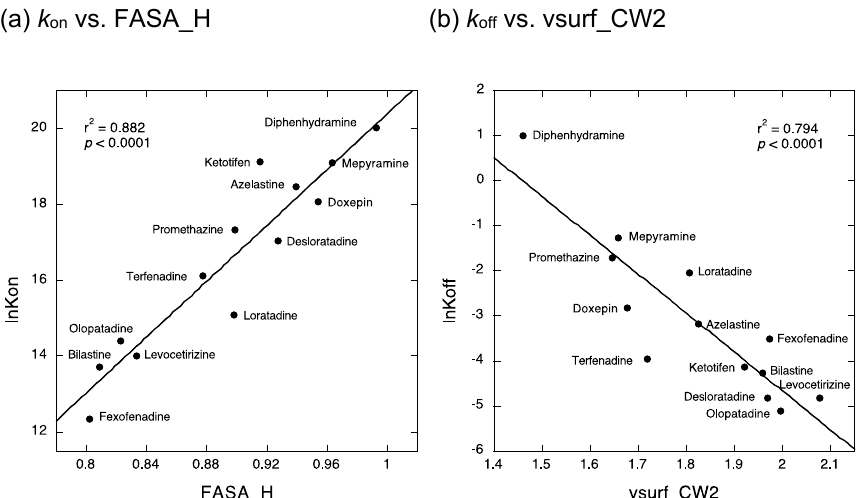
Figure 5. Quantitative structure–activity relationship (QSAR) analyses to identify the physicochemical properties of antihistamines that determine their kinetic binding parameters. Two descriptors, FASA_H (water-accessible surface area of all hydrophobic atoms divided by total water-accessible surface area) and vsurf_CW2 (a 3D molecular field descriptor weighted by capacity factor 2, the ratio of the hydrophilic surface to the total molecular surface) were identified as the structural determinants responsible for the values of k on (a) and k off (b), respectively. k on : rate constant of association; k off : rate constant of dissociation.